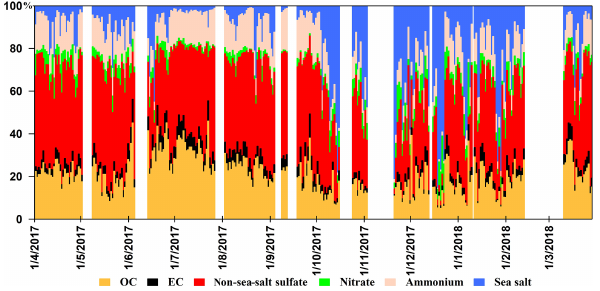
Figure 5. Daily mass fraction of major PM 2 . 5 chemical components measured during 1 April 2017–31 March 2018.